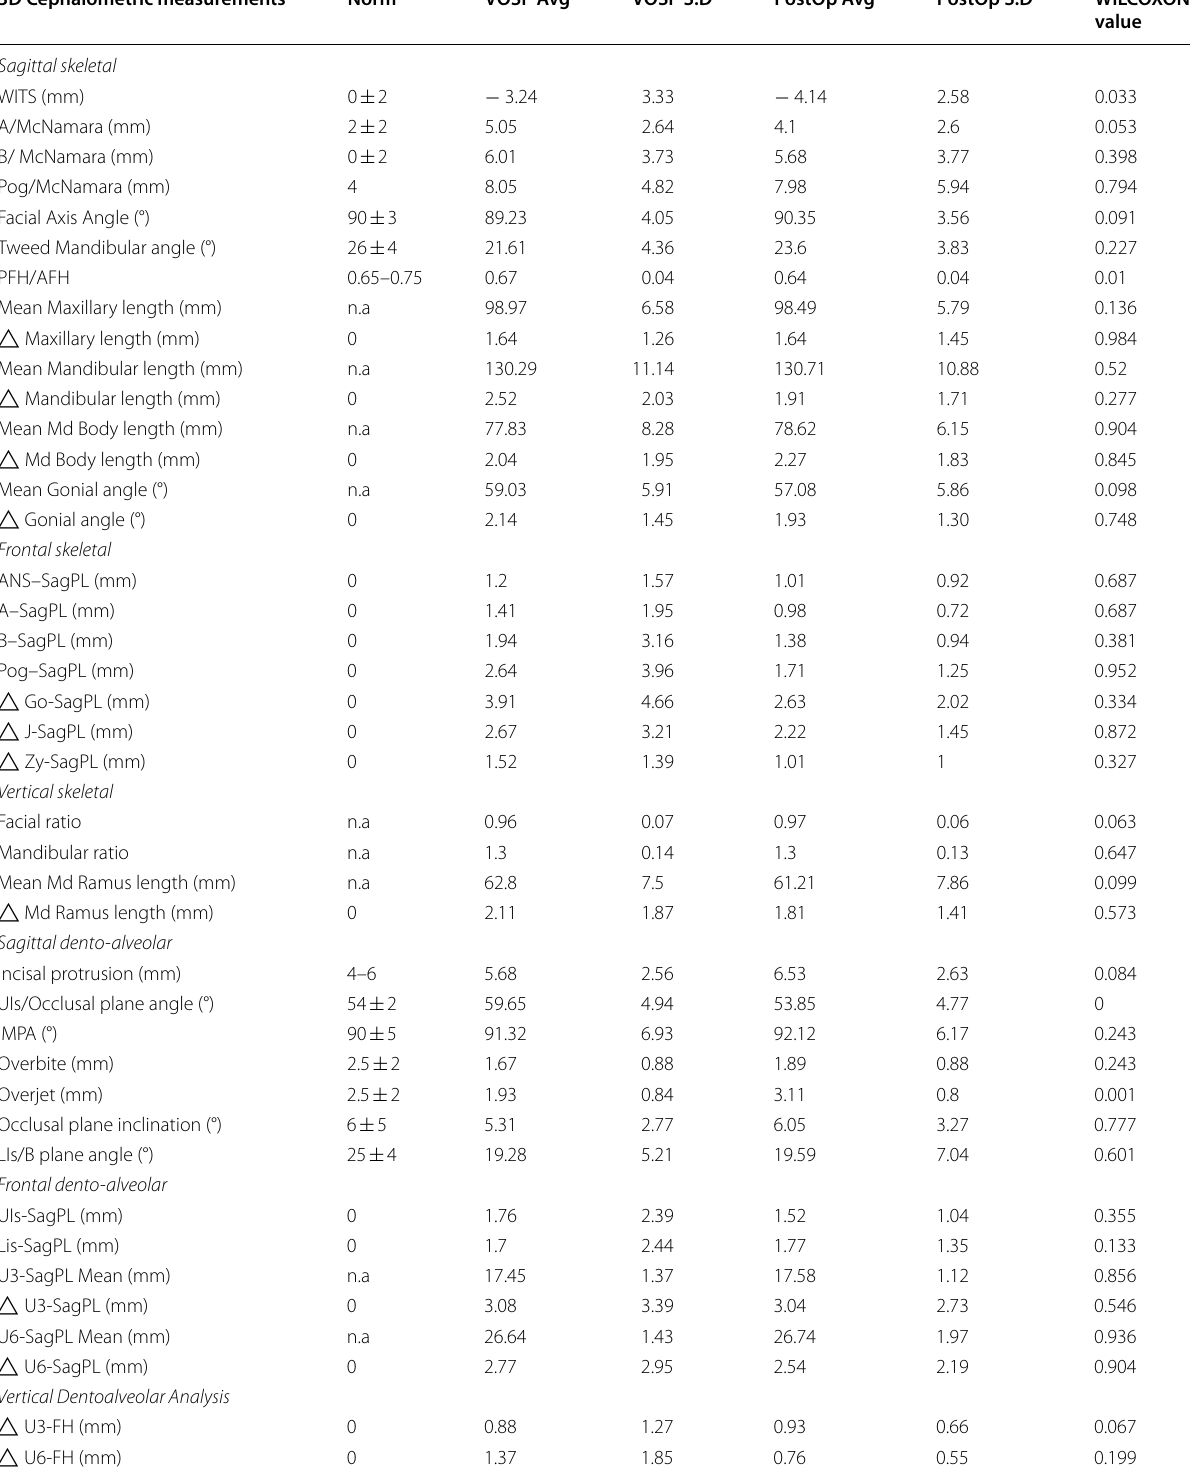
Table 10 VOSP and PostOp 3D cephalometric measurements: Norm values (NORM) [8, 9], Average (Avg), and Standard Deviation